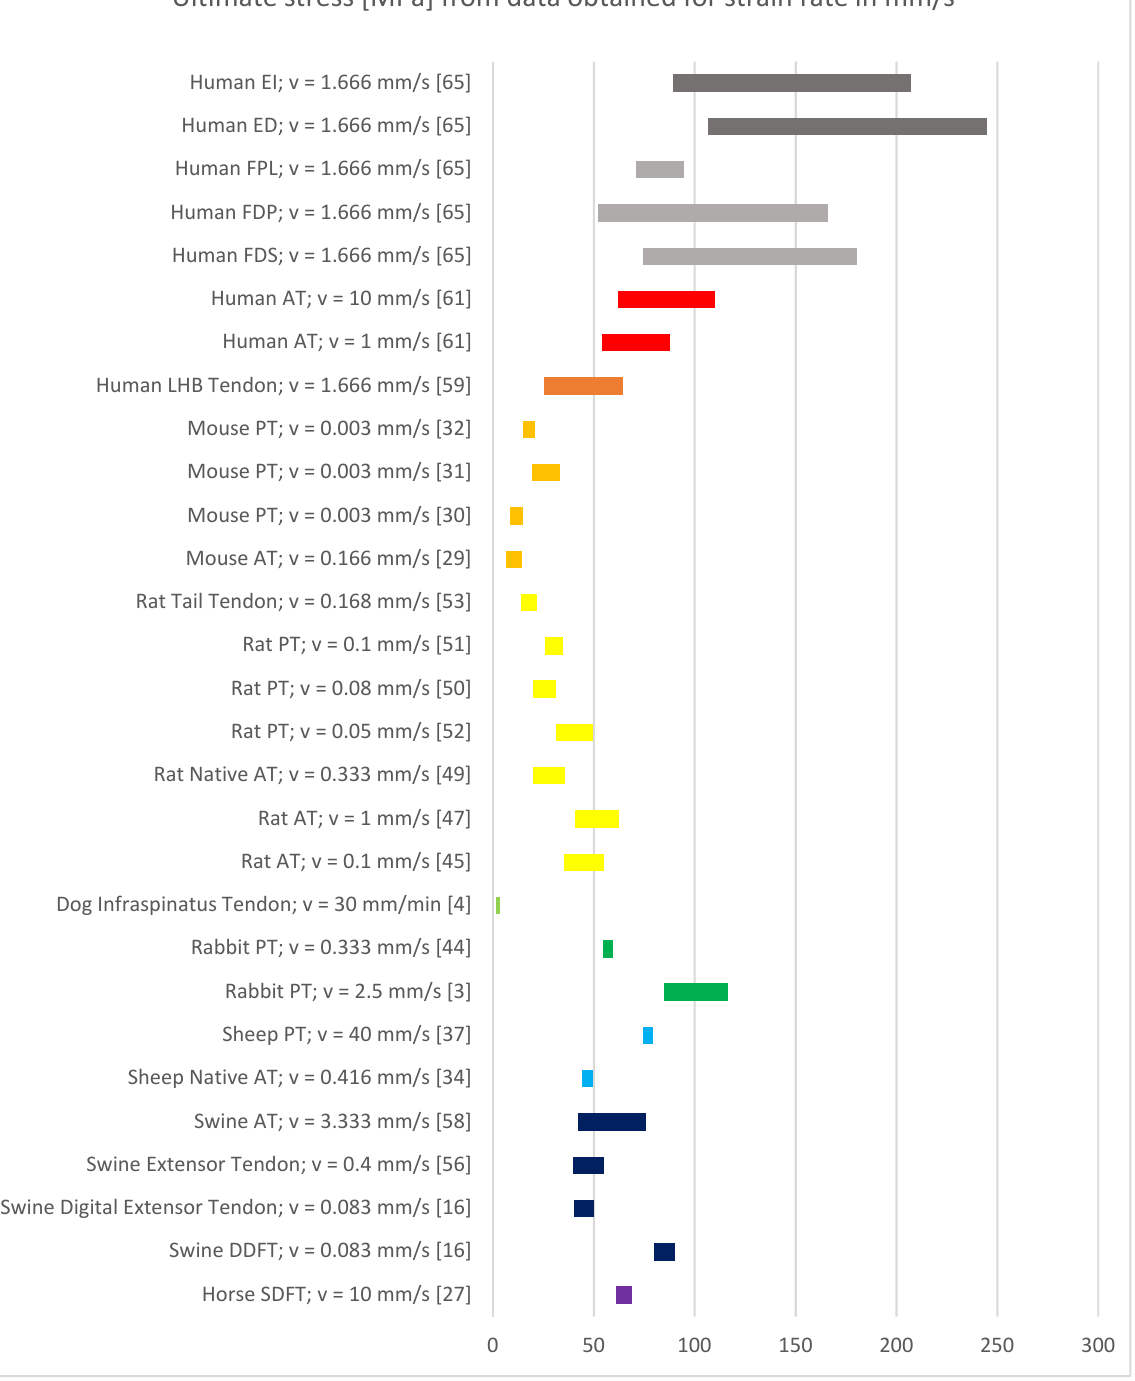
Figure 3. Ultimate stress for the considered animal species (mm/s).